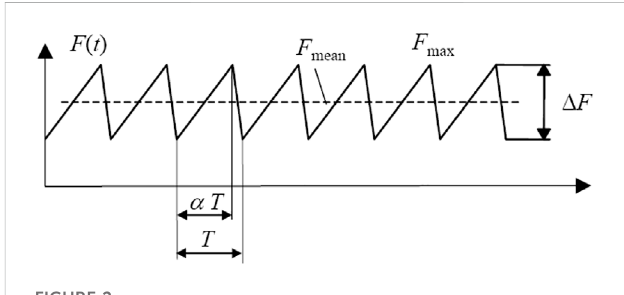
FIGURE 2 The model of steady-state ice